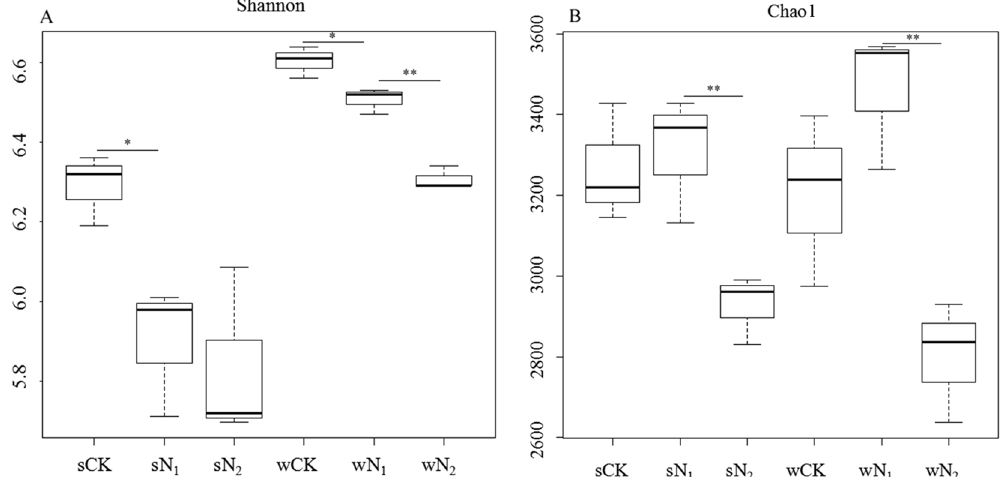
Figure 2. Differences in bacterial community diversity and richness between different N fertilizer regimes. ( A ) Community diversity between different N fertilizer regimes (both wheat and soybean seasons). ( B ) Community richness between different N fertilizer regimes (both wheat and soybean seasons). Asterisks show significant differences between samples ( ** P < 0.01, * P < 0.05, Tukey r-test). sCK, sN 1 and sN 2 indicate different N treatments in the soybean season; wCK, wN 1 and wN 2 indicate different N treatments in the wheat season.